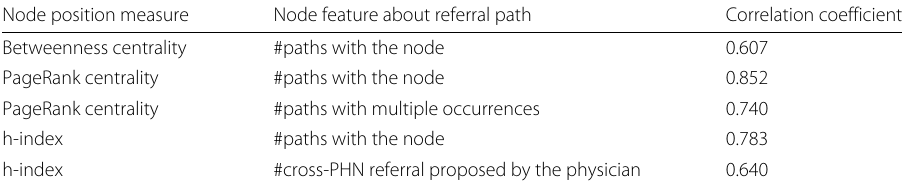
Table 6 Several pairs of strong correlations between node position and node feature on a referral path Node position measure Node feature about referral path Correlation coefficient Betweenness centrality #paths with the node 0.607 PageRank centrality #paths with the node 0.852 PageRank centrality #paths with multiple occurrences 0.740 #paths with the node #cross-PHN referral proposed by the physician 0.640